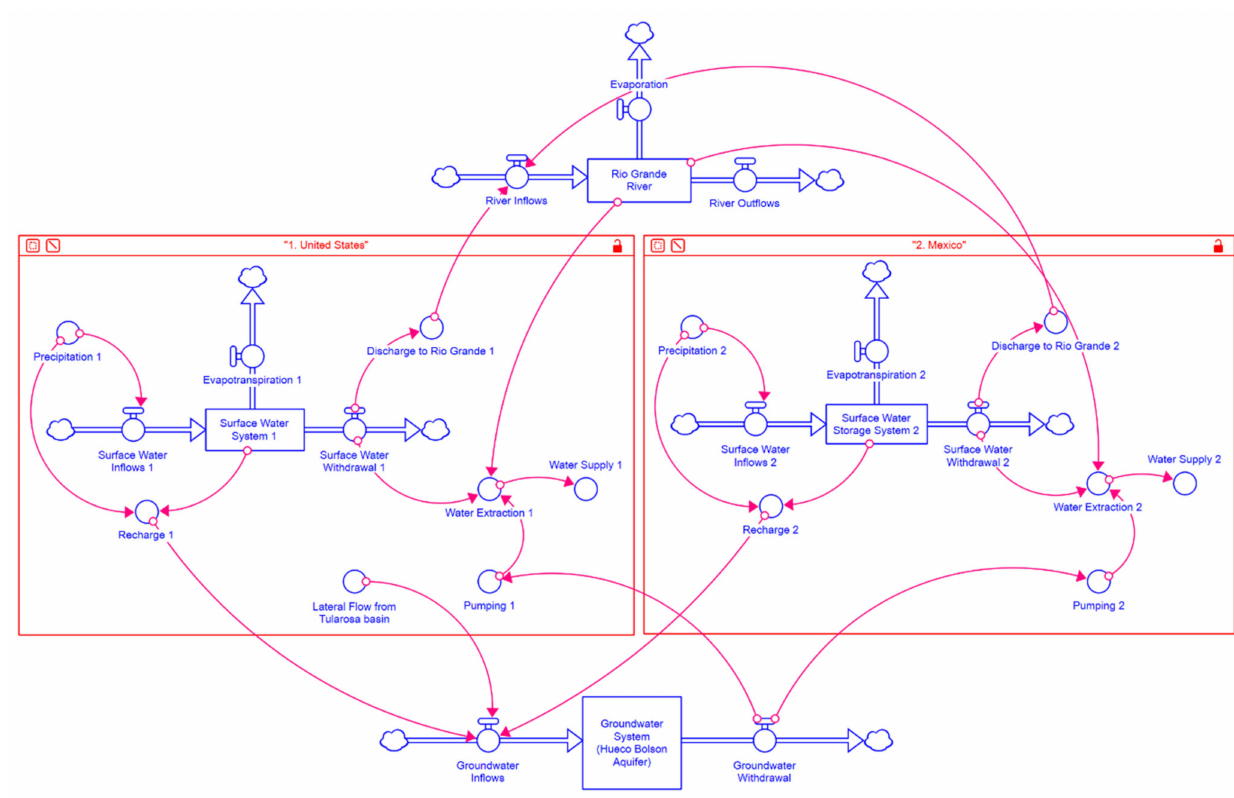
Figure 6. System model concentrating on the water system for a transboundary aquifer—Hueco